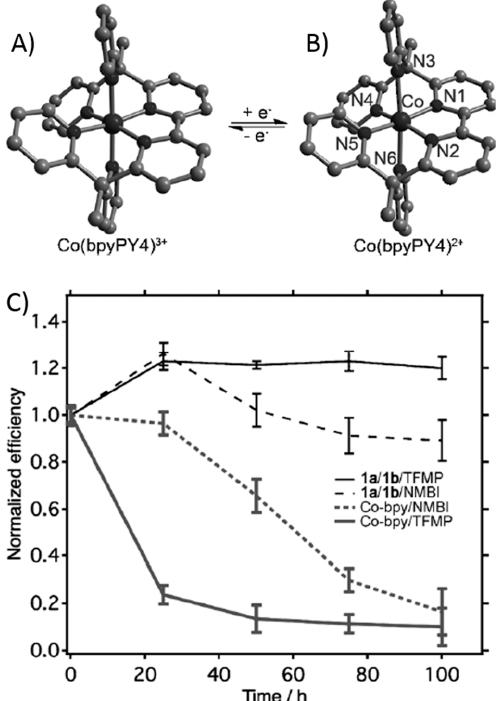
Figure 1. Molecular structures of [Co ‐ (bpyPY 4 )] 2+/3+ in crystals of 1a ( A ) and 1b ( B ). ( C ) Normalized efficiencies of the devices under the aging experiment at full sunlight intensity with a 400 ‐ nm UV cut ‐ off filter. Two Lewis bases, NMBI and TFMP, were alternatively used with 1a/1b and [Co(bpy) 3 ] 2+/3+ . Adapted and reprinted with permission from